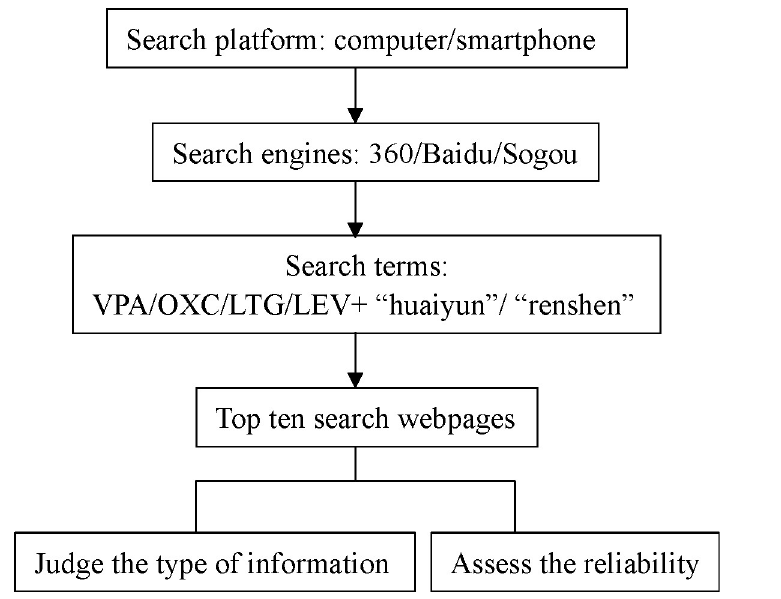
Fig 1. Search flow